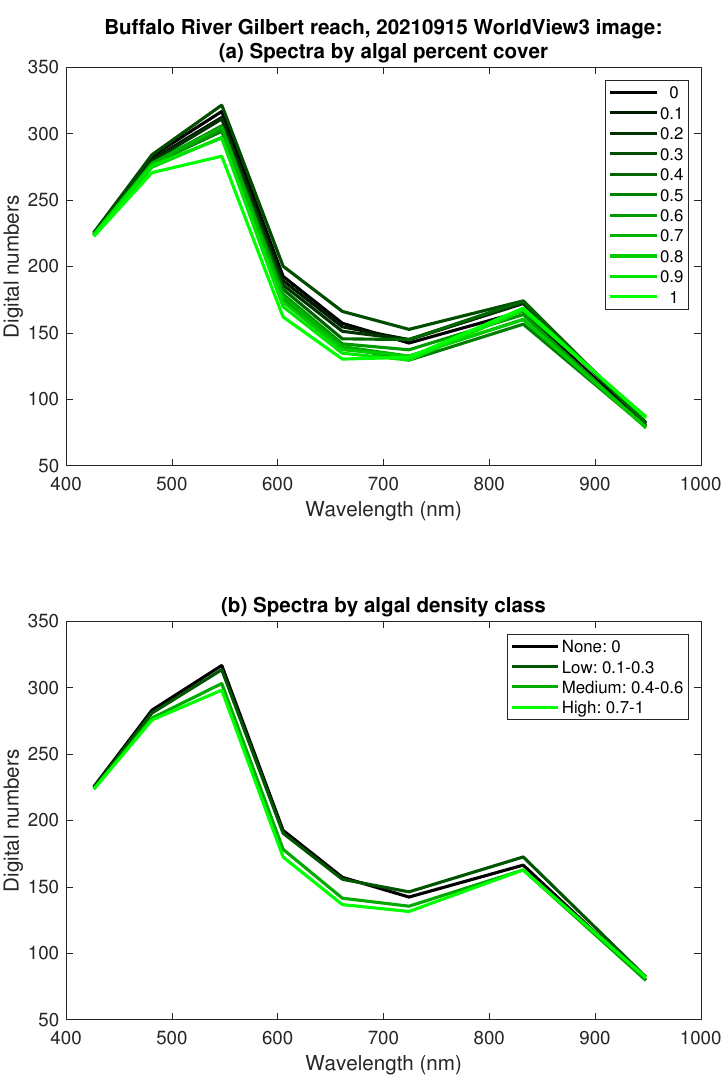
Figure 9. Example spectra extracted from the 15 September 2021, WorldView3 image of the Gilbert reach and then grouped by ( a ) percent cover of benthic algae and ( b ) algal density class. The spectra plotted here are the means of all pixels with each level of percent cover and density